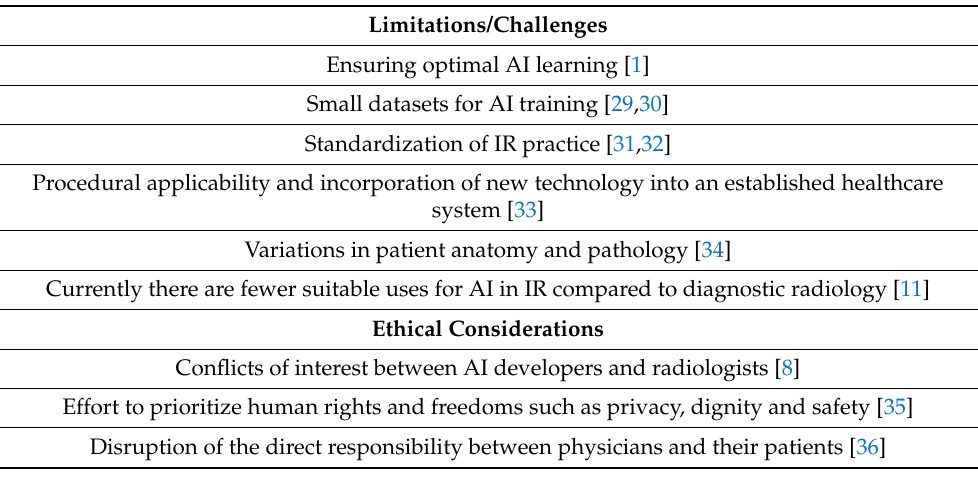
Table 2. Limitations and ethical considerations associated with the implementation of AI into